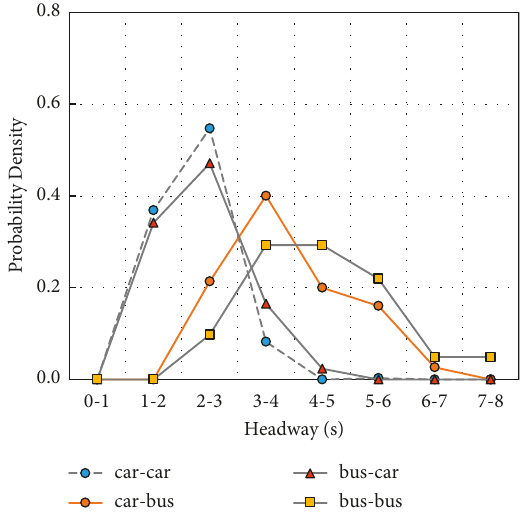
Figure 8: The distribution of headway in four car-following scenarios [30].